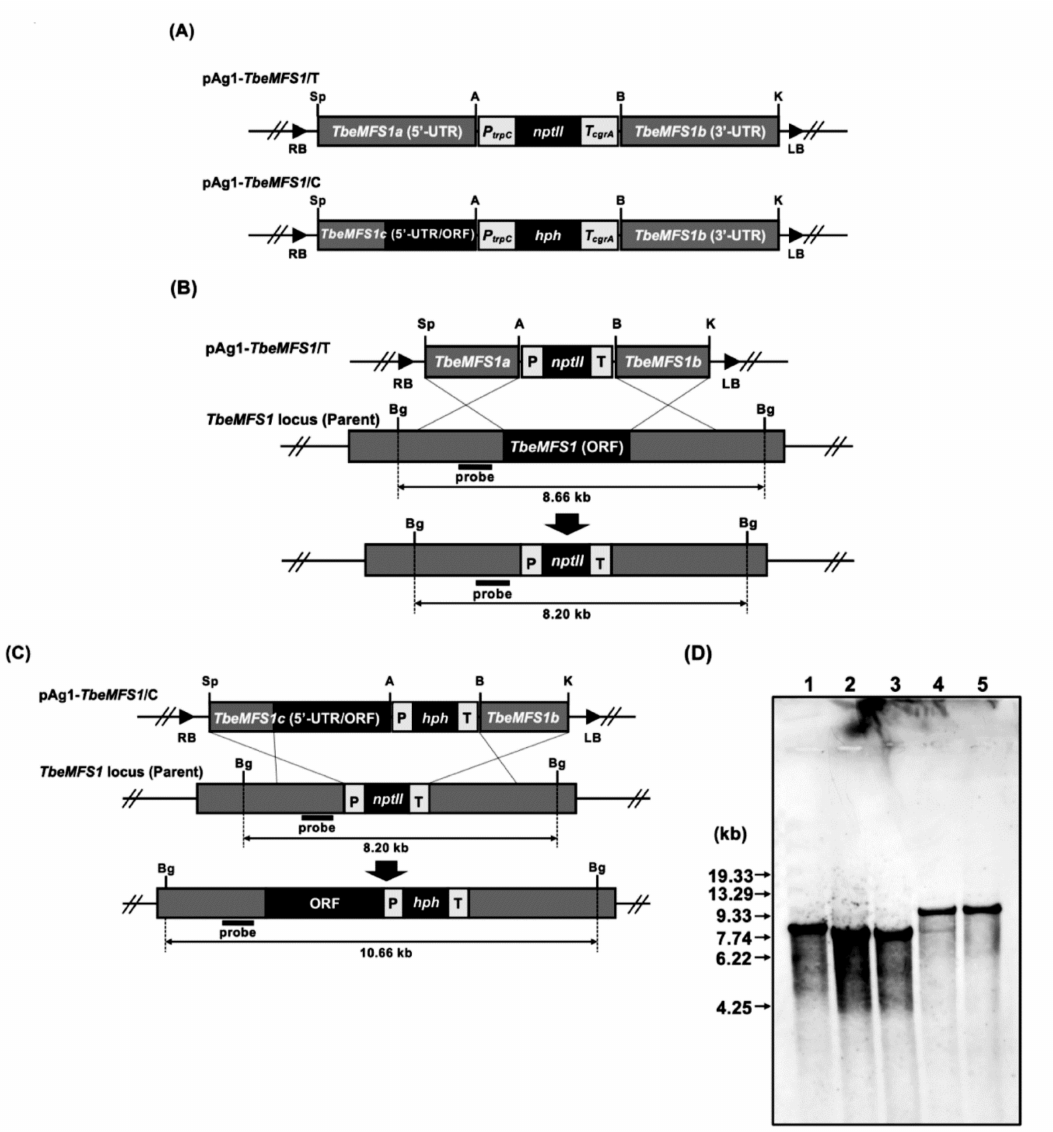
Figure 1. Disruption of the TbeMFS1 gene of T. benhamiae ∆ TbeKu70-5-1 by gene replacement strategy. ( A ) Schematic representation of the binary TbeMFS1 -targeting and TbeMFS1 -complementation vectors, pAg1- TbeMFS1 /T and pAg1- TbeMFS1 /C. The selectable marker cassettes are composed of A. nidulans trpC promoter ( PtrpC ), E. coli nptII or hph gene, and the A. fumigatus cgrA terminator ( TcgrA ). LB and RB, left and right borders, respectively; A, ApaI; B, BamHI; Bg, BglII; K, KpnI; S, SpeI. ( B , C ) Schematic representation of the TbeMFS1 locus before and after homologous recombination with pAg1- TbeMFS1 /T ( B ) and pAg1- TbeMFS1 /C ( C ). ( D ) Southern blotting analysis. Lane 1, ∆ TbeKu70-5-1 (Parent strain); Lane 2 to 3, ∆ TbeMFS1-17-1, -and -18-1; Lane 4 to 5, TbeMFS1/C-18-1-10 and -16. An 878-bp fragment of the TbeMFS1 locus was amplified by PCR with the primer pair AbF152-AbR141 (Table S1) and used as a hybridization probe. DNA standard fragment sizes are shown on the